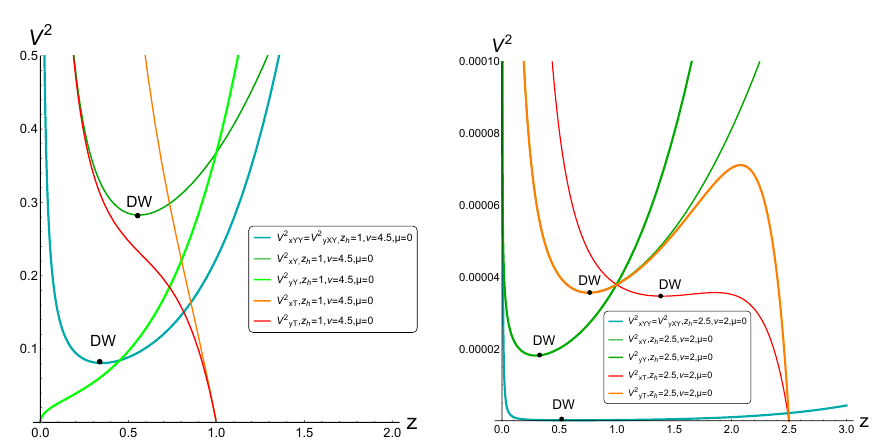
Figure 3. The comparison of the e ff ective potentials Wilson loops and HEE calculated in model [1] for µ = 0, c =